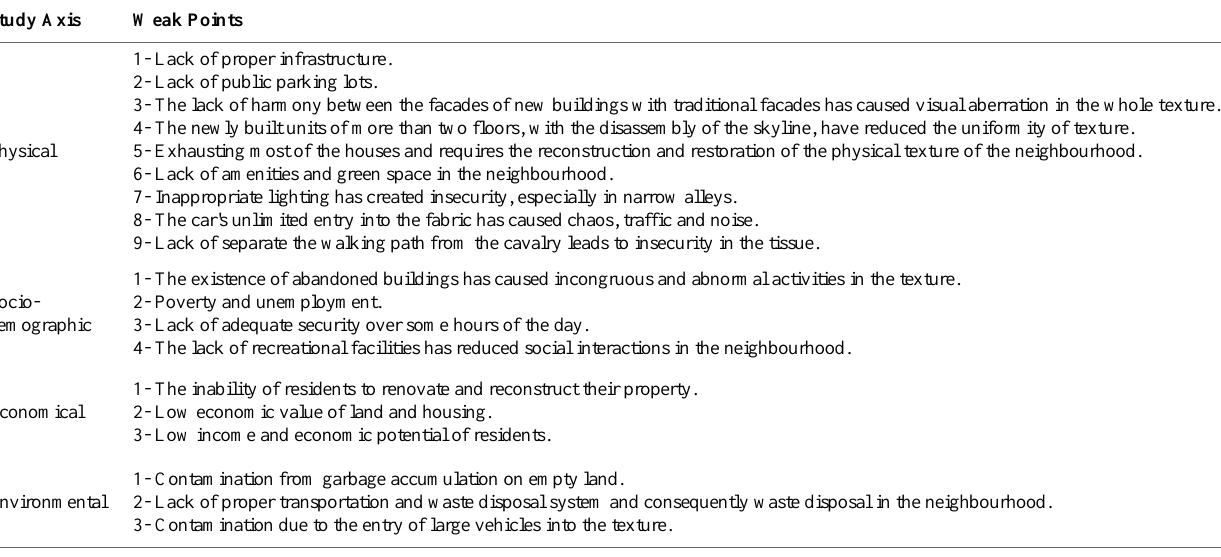
Table 2. Analysis of the weaknesses of the Neighbourhoods using the SWOT technique